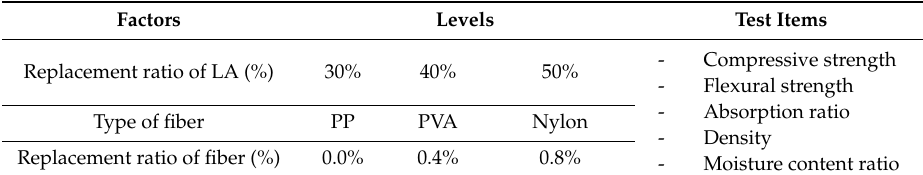
Table 1. Experimental